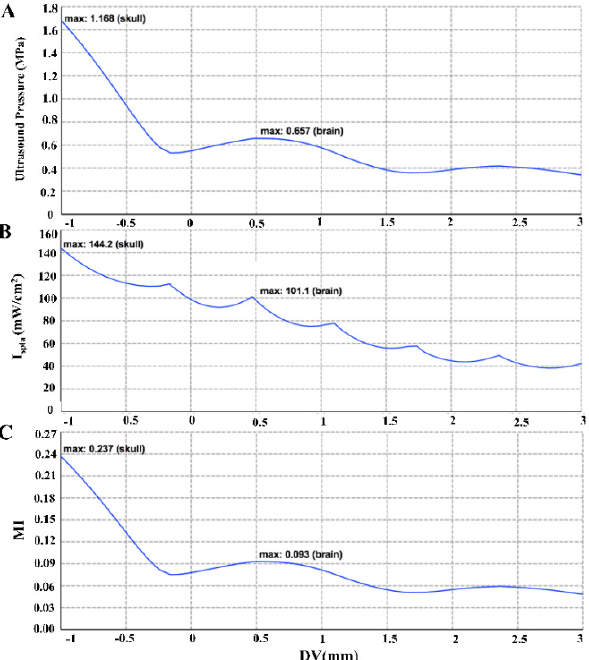
Figure 8. ( A ) The change in sound pressure as the depth in the brain increases. ( B ) The change in sound intensity as the depth in the brain increases. ( C ) The change in mechanical index with increasing brain depth. Point zero on the x axis represents the boundary between the brain tissue and the skull, the part less than zero ( − 1–0 mm) represents the skull, and the part greater than zero (0–4 mm) represents the brain tissue.